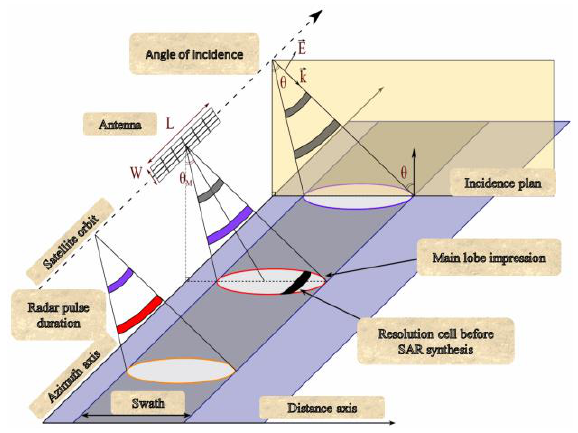
Figure 1. Radar acquisition geometry for Stripmap mode (Lardeux 2008)